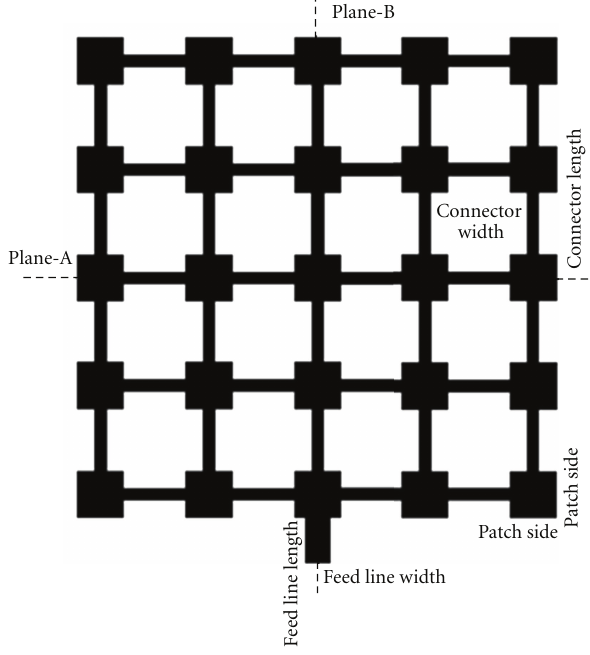
Figure 1: 5 × 5 microstrip antenna